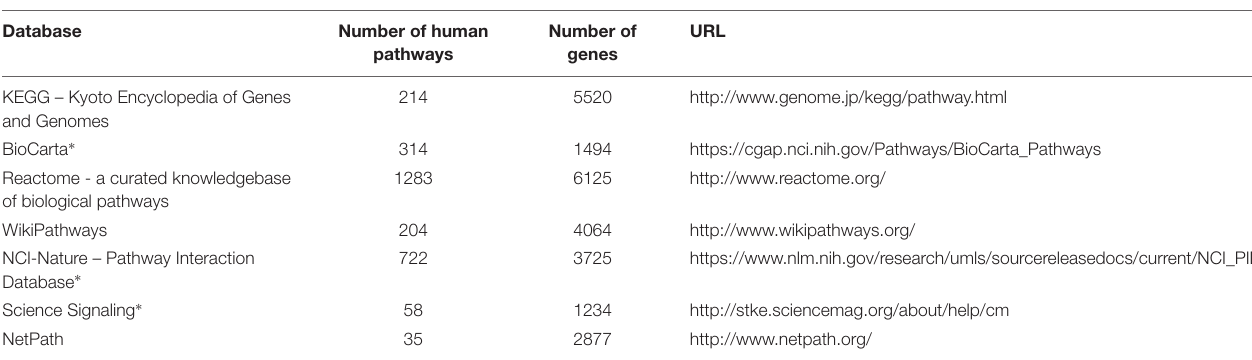
TABLE 1 | Pathway data